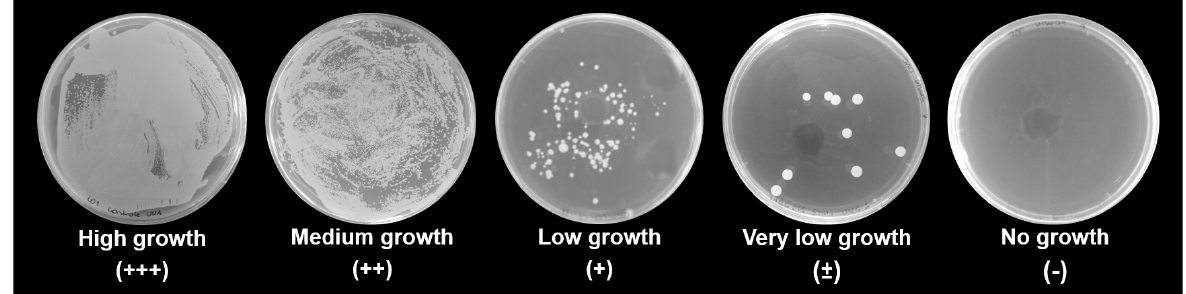
Figure 2. Visual evaluation and qualitative classification of the cell growth. High growth: a layer of colonies covering a relatively large area of the agar (+++), Medium growth: colonies too numerous for an accurate count (++), Low growth: total colonies count > 10 and < 100 (+), Very low growth: total colonies count ≤ 10 (±), No growth: no colonies formed